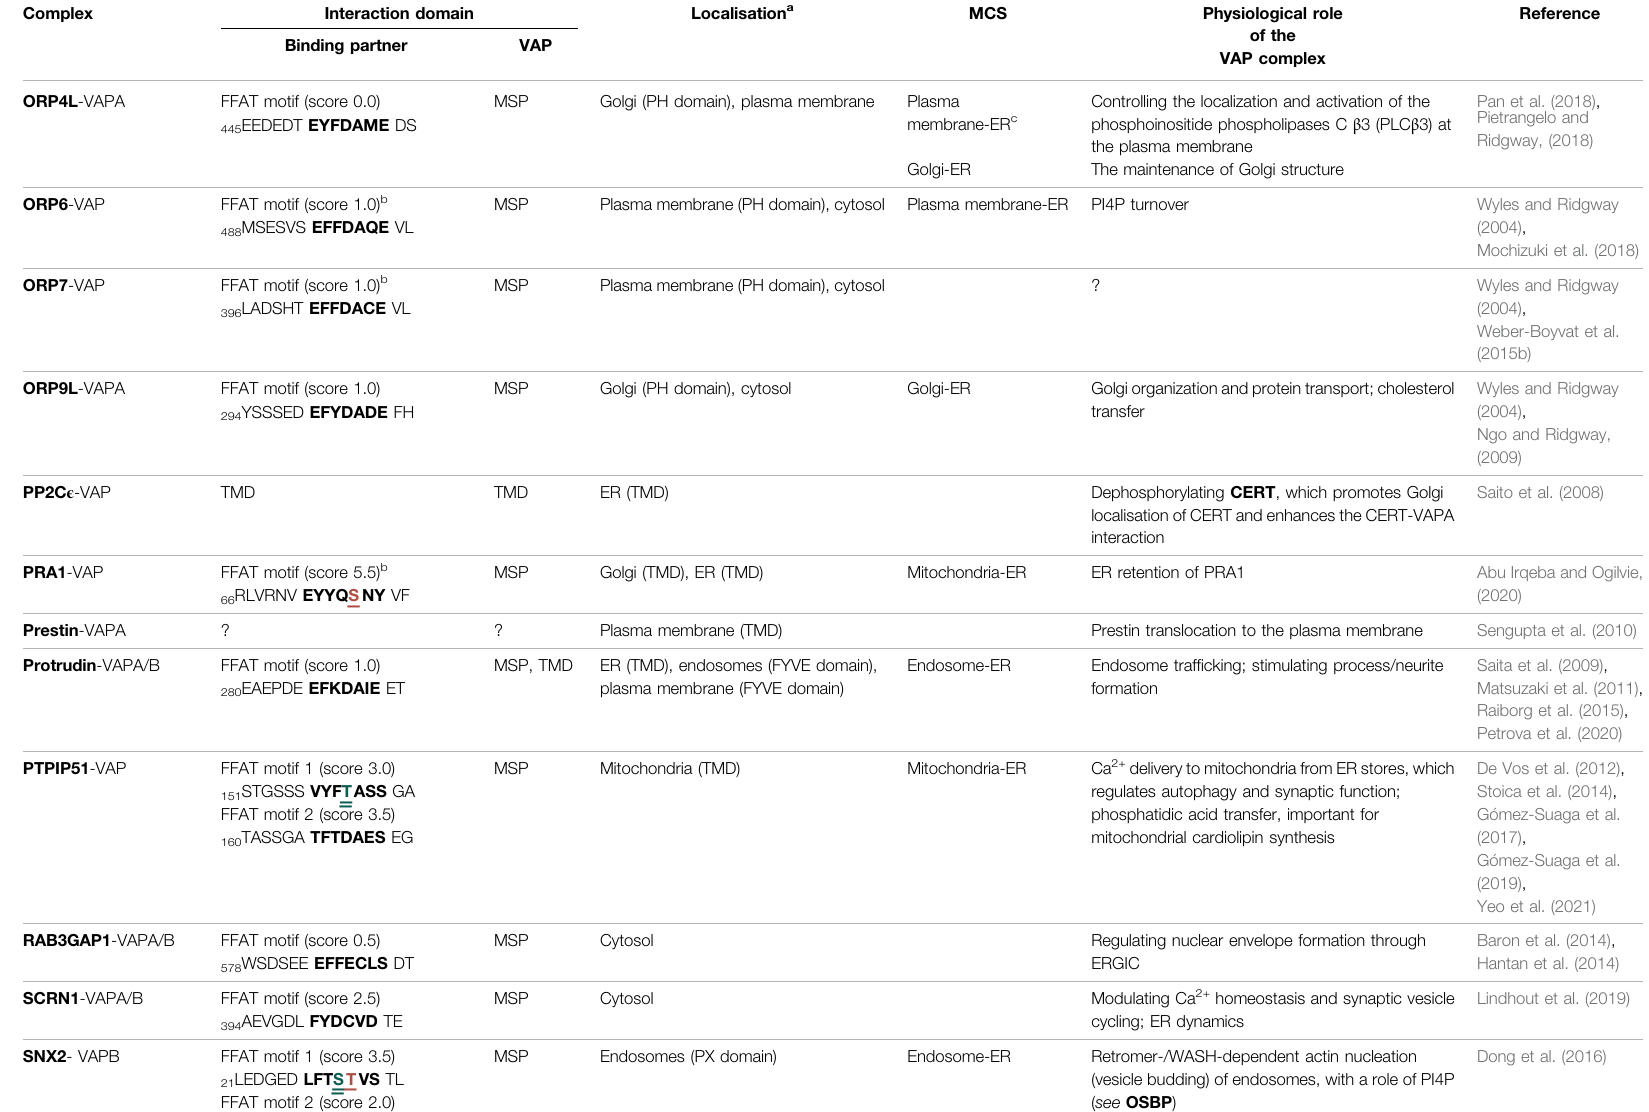
TABLE 1 | ( Continued ) An overview of experimentally con fi rmed VAP binding partners in mammalian